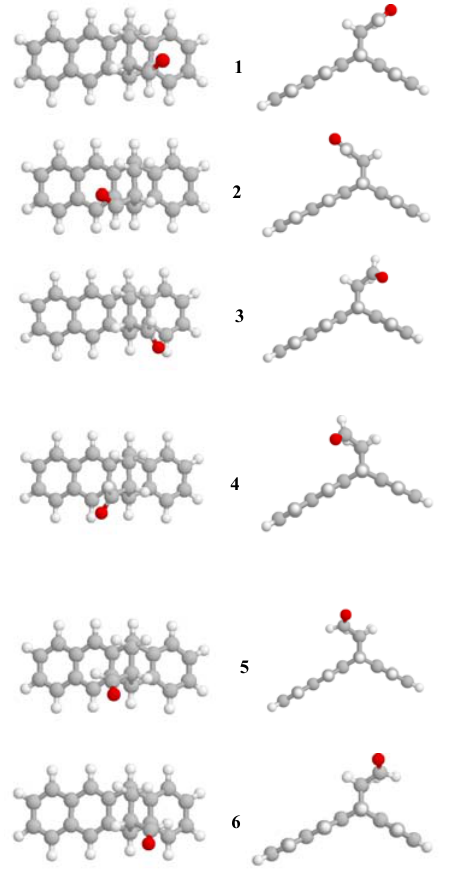
Table 1. Relative energies, kcal/mol, and predicted vibrational frequency corresponding to the C=O stretching mode (cm − 1 ) of the six predicted conformations of 5,12-dihydro-5,12- ethanonaphthacene-13-carbaldehyde. Conf. No.